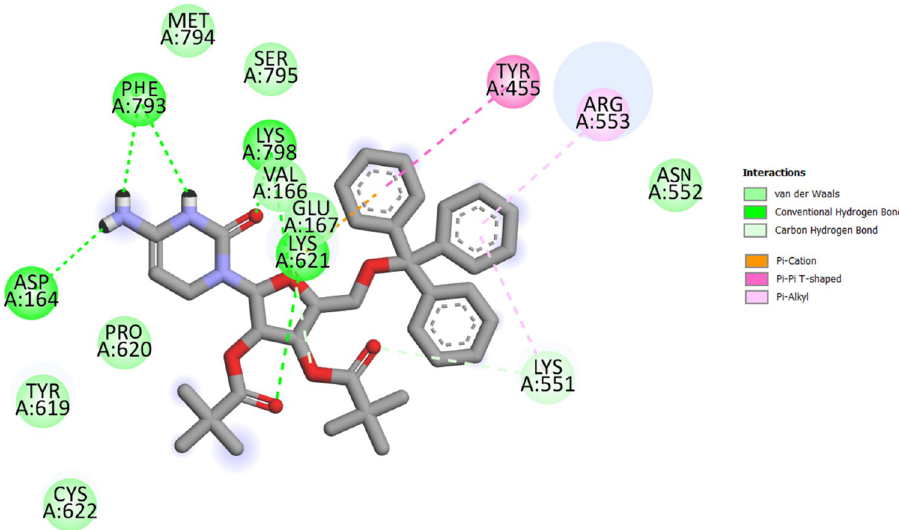
of a putative ligand of a known 3D structure with a target protein. To validate docking studies, co-crystallized remdesivir was redocked with RdRp enzymes. The binding mode and interac- tions of the control remdesivir with the enzymes are given in Fig 4. In this study, several cyti- dine derivatives were studied in silico to determine their possible binding energies and interaction modes at the active site of SARS-CoV-2 RdRp (Table 2). Table 2 presents the esti- mated average binding energies of compounds with the enzymes (Fig S2 in S1 File). According to the docking screening results, eight derivatives ( 6 – 10 and 13 – 15 ) with the strongest binding energies were selected to describe the binding mode of cytidine inhibitors. Comparatively, the aromatic derivatives exhibited better binding scores than the aliphatic derivatives. Fig 5